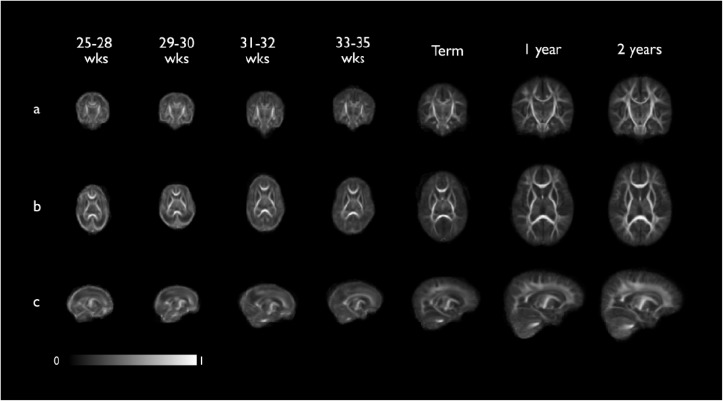
Coronal (a), axial (b) and sagittal (c) views of the seven population-averaged fractional anisotropy (FA) atlas at the 7 developmental time points. Intensity bar indicates FA value.These registration templates are freely available at www.brain-development.org.